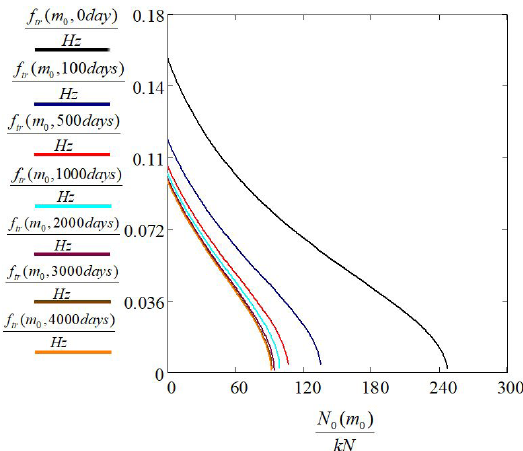
Figure 6. Results for Δ T =